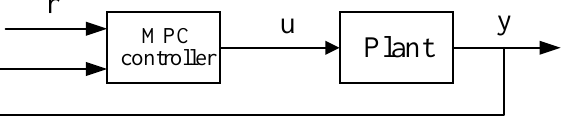
Figure 3. Closed-loop control system with the MPC controller